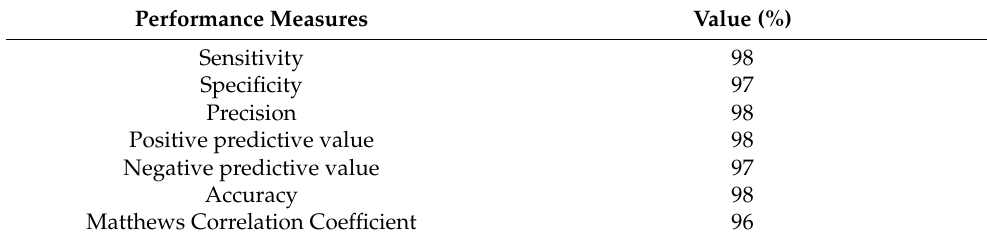
Table 1. Performance of the PD Extractor.py.